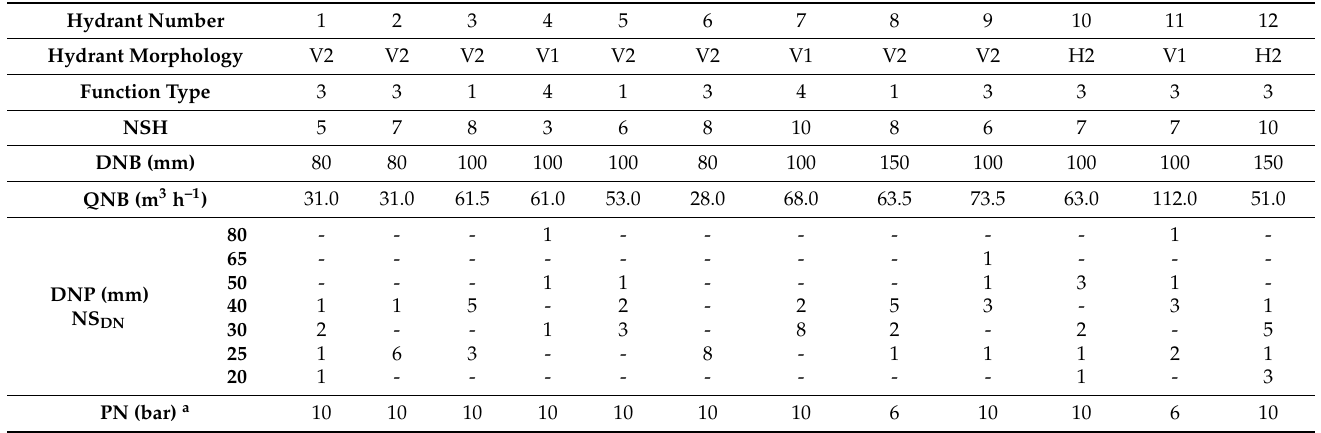
Table 2. Multioutlet hydrant